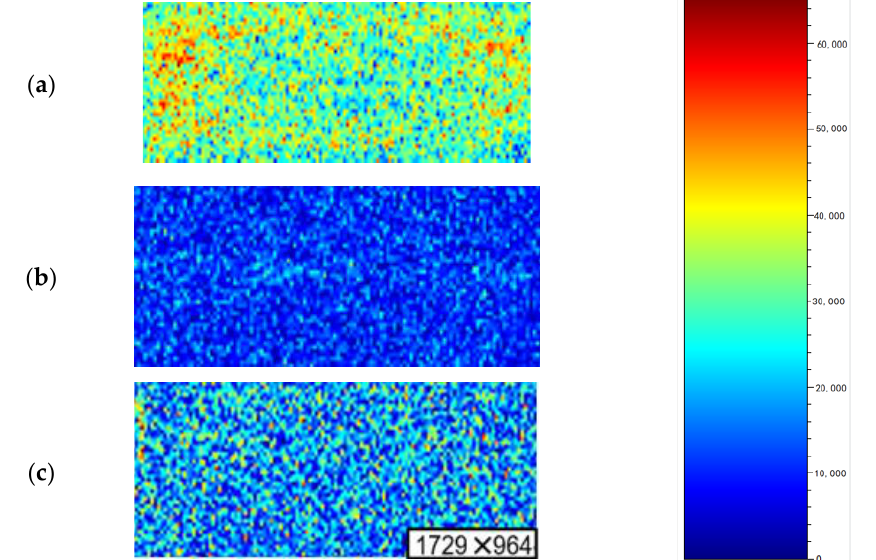
Figure 6. ( a ) Core saturated water; ( b ) saturated fluorine oil; ( c ) after imbibition of 2D nano blackcard 2D pseudocolor imaging scan results.